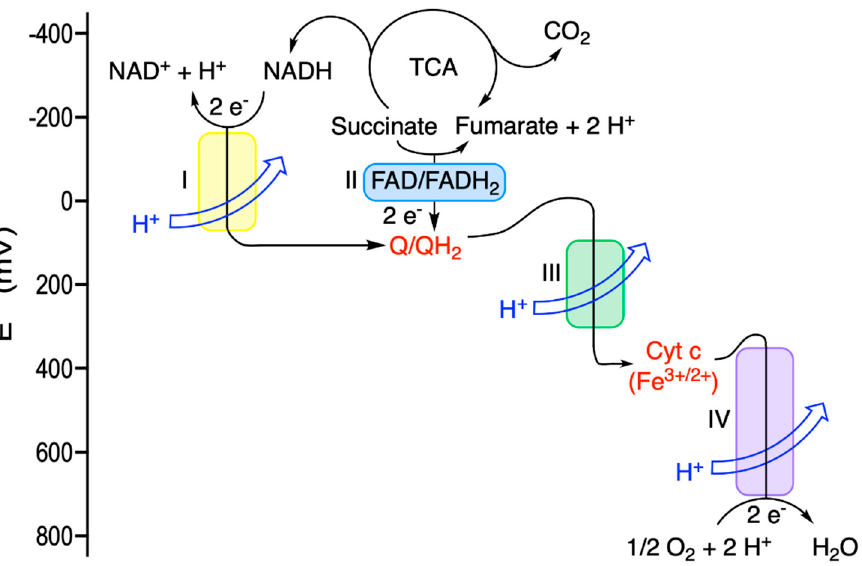
Figure 3. Electron flow from NADH and FADH 2 to O 2 in the mitochondrial respiratory chain. While the first reactions involve the transfer of H − + H + to the acceptor Q, complexes III and IV act as electron wires coupled to proton